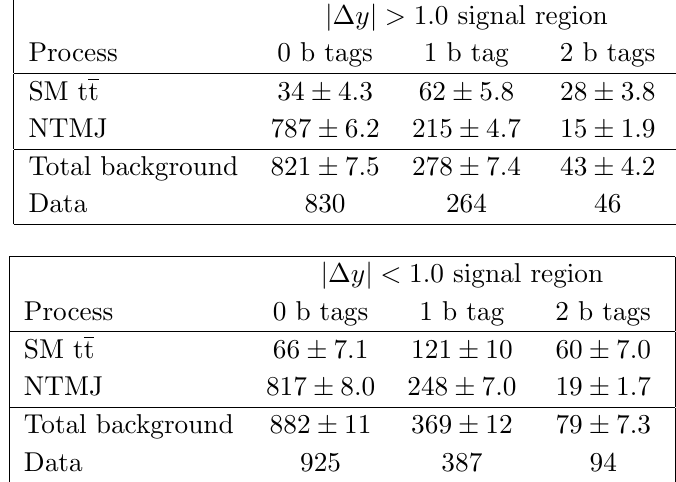
Table 4 . Number of events in the signal region for the fully hadronic analysis. The expected yields for SM backgrounds are obtained from the maximum likelihood (cid:12)t to data described in the text. The uncertainties reported for the total expected background include the statistical uncertainties on the simulation and all the posterior systematic